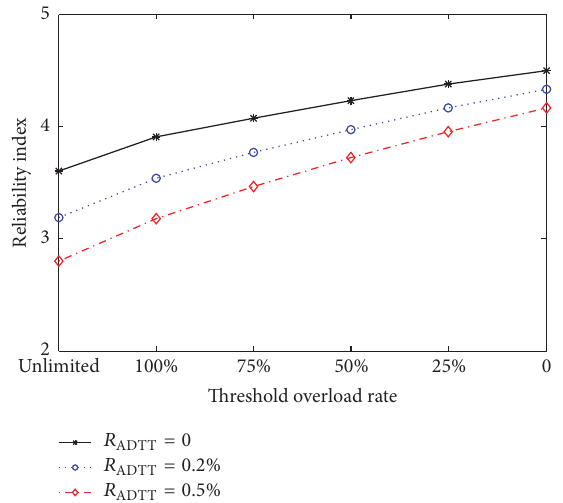
Figure 12: Influence of the threshold overload rate on the fatigue reliably